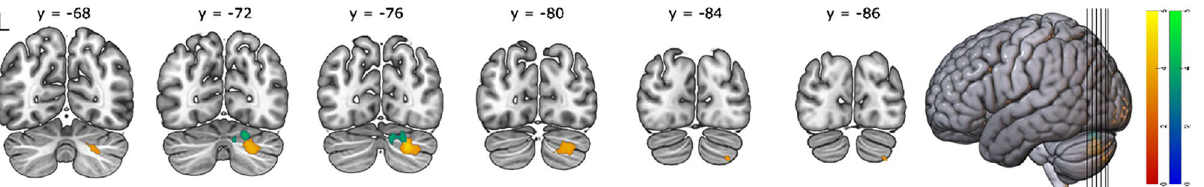
Figure 4. t statistical map from seed-to-voxel exercise > rest, post > pre. Slice views of significant peaks (cluster threshold p < 0.05 FWE-corrected, p < 0.001 uncorrected at voxel level) using the left hippocampus (blue-green) and left amygdala (red-yellow) as seed regions. Increased connectivity observed between the left hippocampus (seed) and the right crus I and lobule 6 of the cerebellum (blue-green) (T = 4.76, k = 95, p‑ FWE = 0.040) and between the left amygdala (seed) and the right crus I and II of the cerebellum (red-yellow) (T = 5.21, k = 254, p -FWE < 0.001).